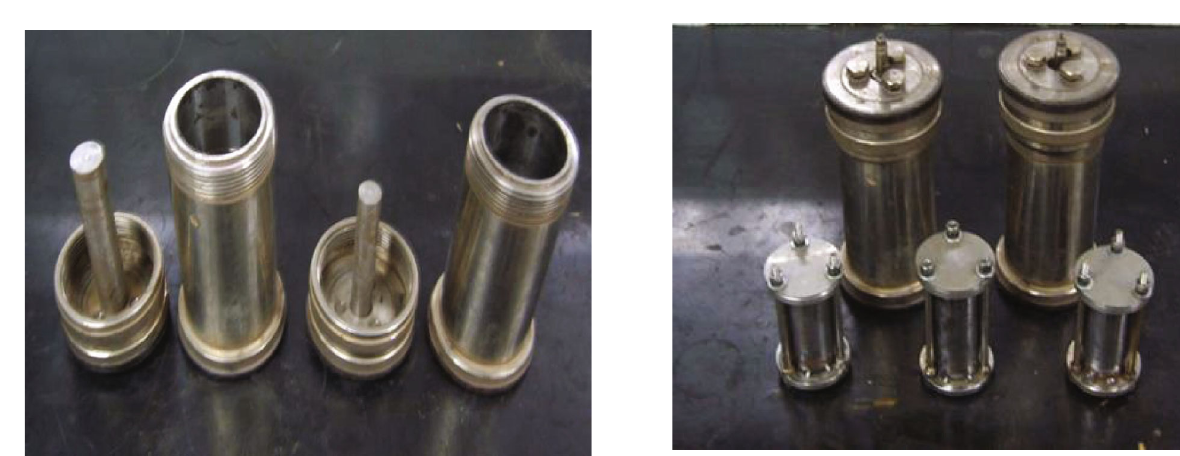
Figure 1: Picture of accretion experiment